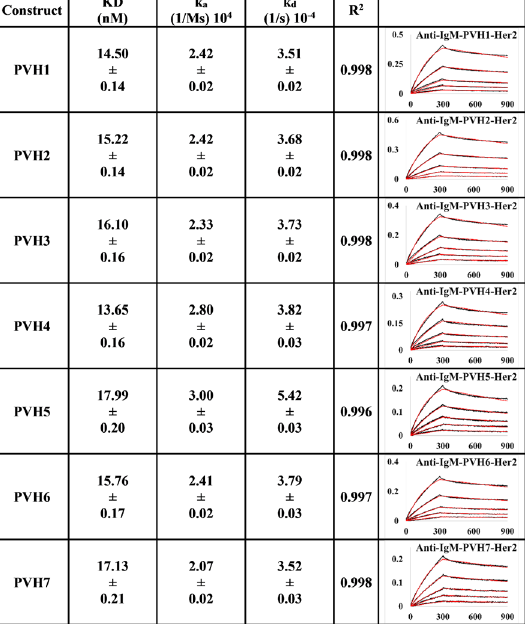
Figure 5. BLI measurement of pertuzumab IgM variants (PVH1-7) interacting with Her2 using PpL biosensor to capture the light chain of IgM. KD, k , k , and R 2 and fitting curves are shown according to the 1:1 fitting model. PR indicates poor responses a d where measurements with a poor R 2 value are shown in red. The x-axis and y-axis of the graph represent time (s) and response (nM), respectively. All values are rounded off to 2 decimal places. Triplicate experiments were performed, and standard errors were reported